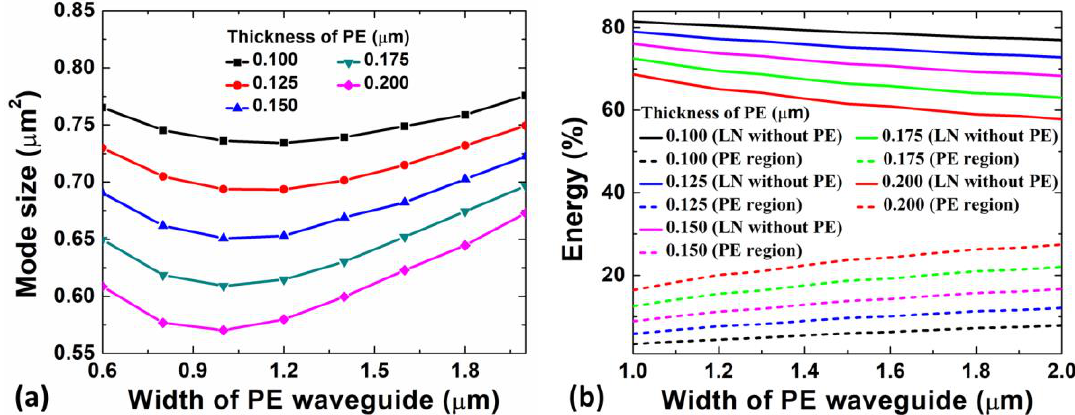
Figure 3. ( a ) Relationship between the mode size and the width and thickness of the PE waveguide. ( b ) Relationship between the optical power and the width and thickness of the PE waveguide.